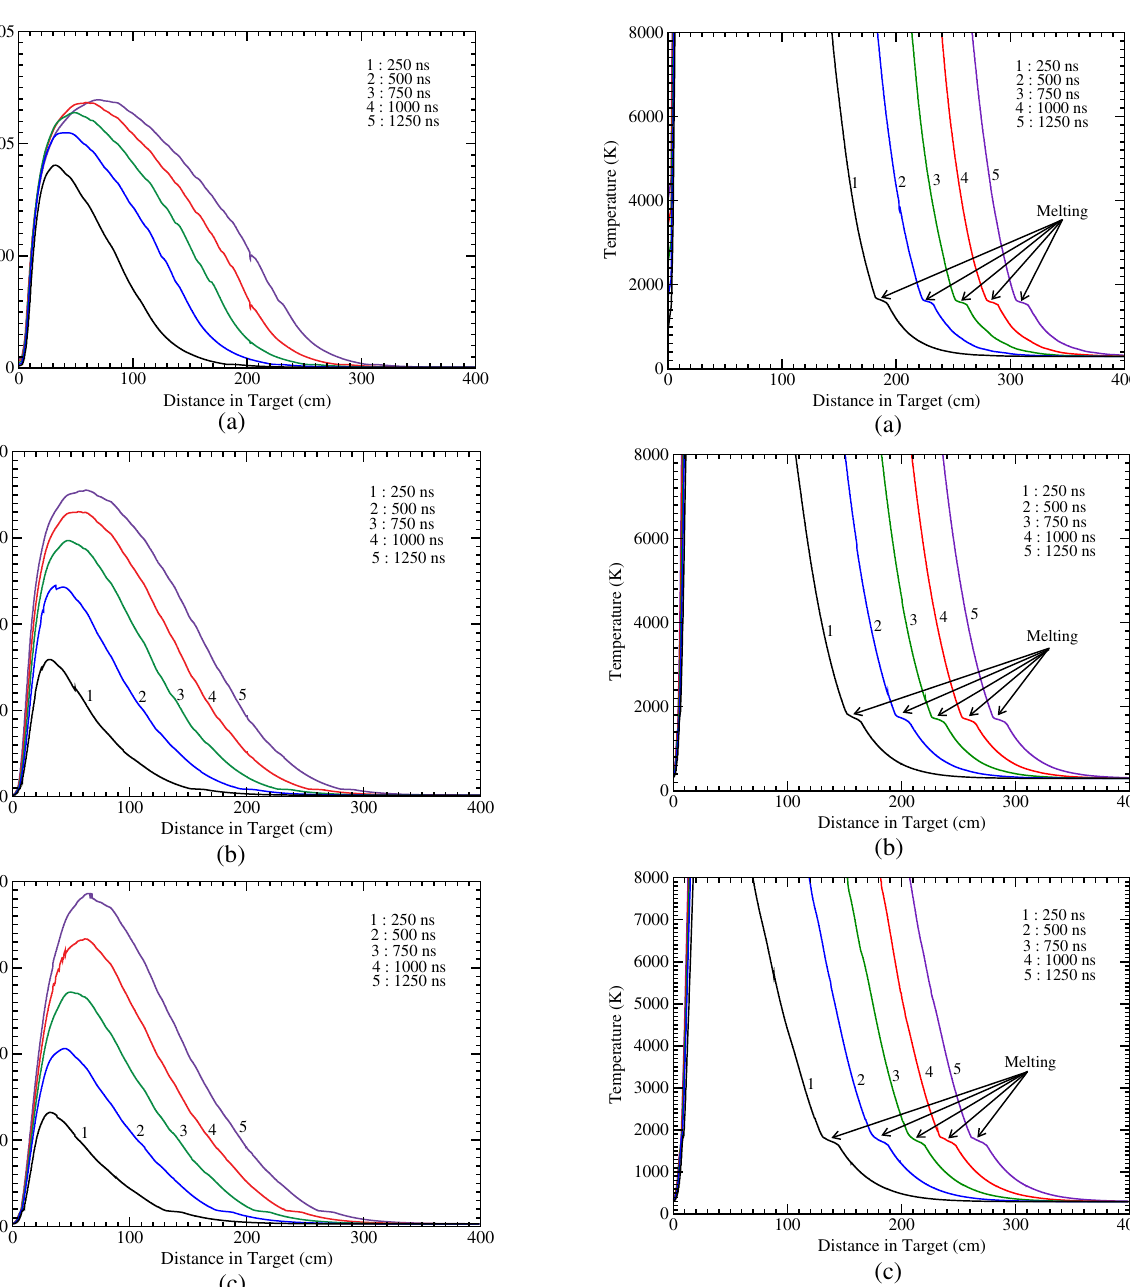
FIG. 5. Target temperature profiles vs distance in the target at different times: (a) along the axis at r ¼ 0 , (b) at r ¼ 1 mm and (c) r ¼ 2 mm.